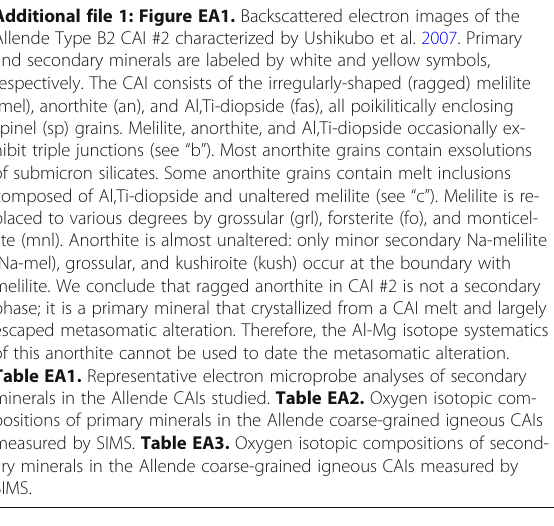
Table EA1. Representative electron microprobe analyses of secondary minerals in the Allende CAIs studied. Table EA2. Oxygen isotopic com- positions of primary minerals in the Allende coarse-grained igneous CAIs measured by SIMS. Table EA3. Oxygen isotopic compositions of second- ary minerals in the Allende coarse-grained igneous CAIs measured by